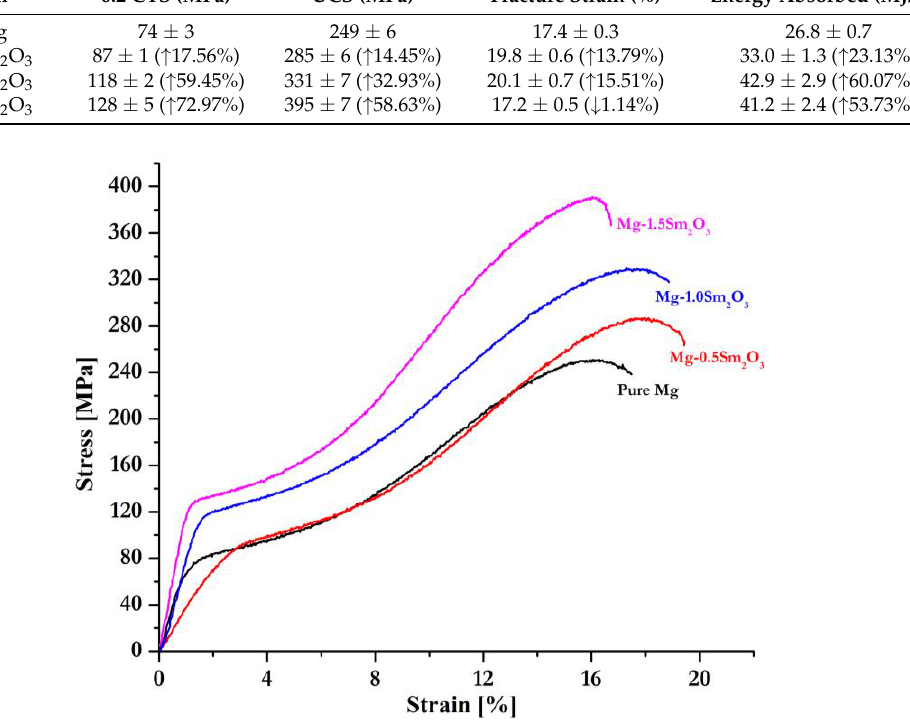
Figure 2. Stress–strain curves of pure Mg and the synthesized Mg-Sm 2 O 3 nanocomposites during compression loading.